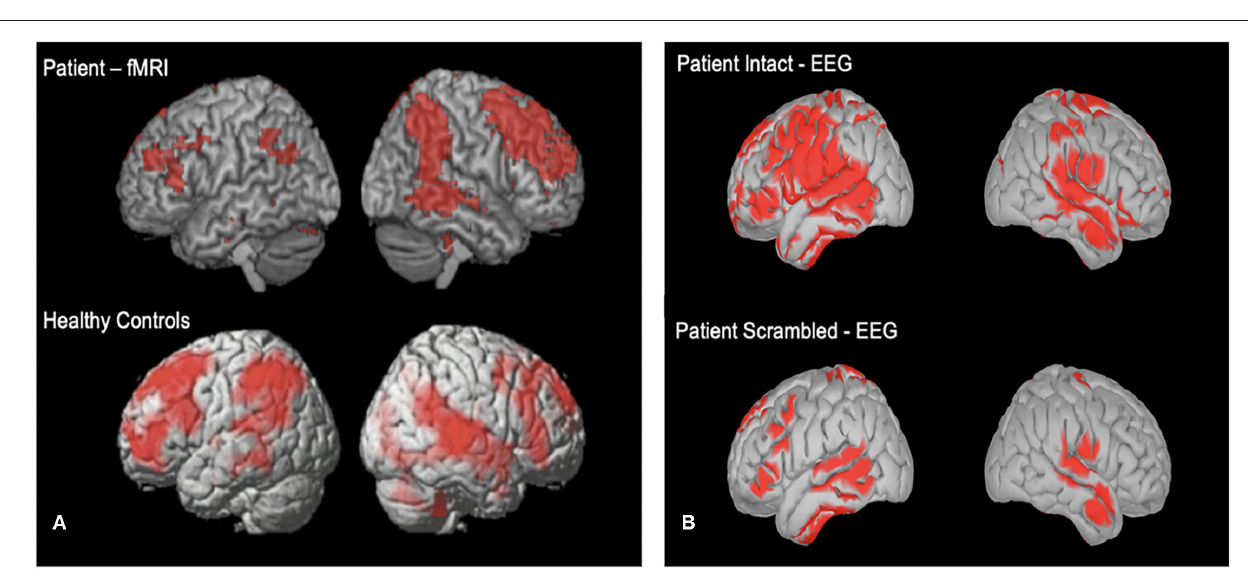
FIGURE 4 | (A) One acutely unresponsive patient who underwent fMRI imaging while listening to the soundtrack from part of the movie “Taken”. (B) Cortical reconstruction of EEG activity recorded from one unresponsive patient while listening to the “Taken” audio (top) and a scrambled control version of the clip (bottom). EEG activity is source localized following previously described method